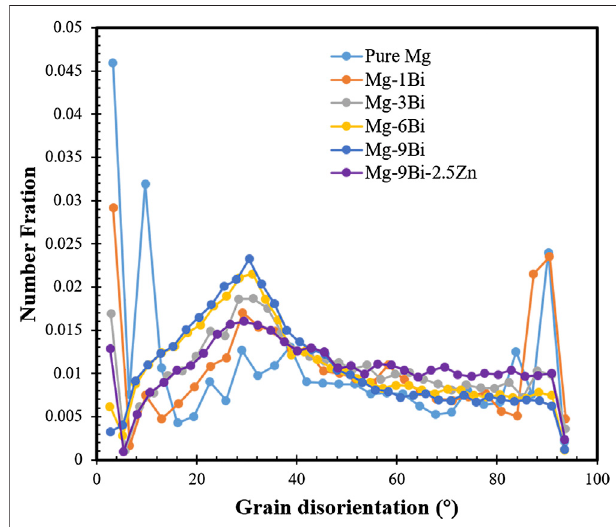
FIGURE 9 | Grain disorientation pro fi le of as-extruded pure Mg and alloys studied in the present work.